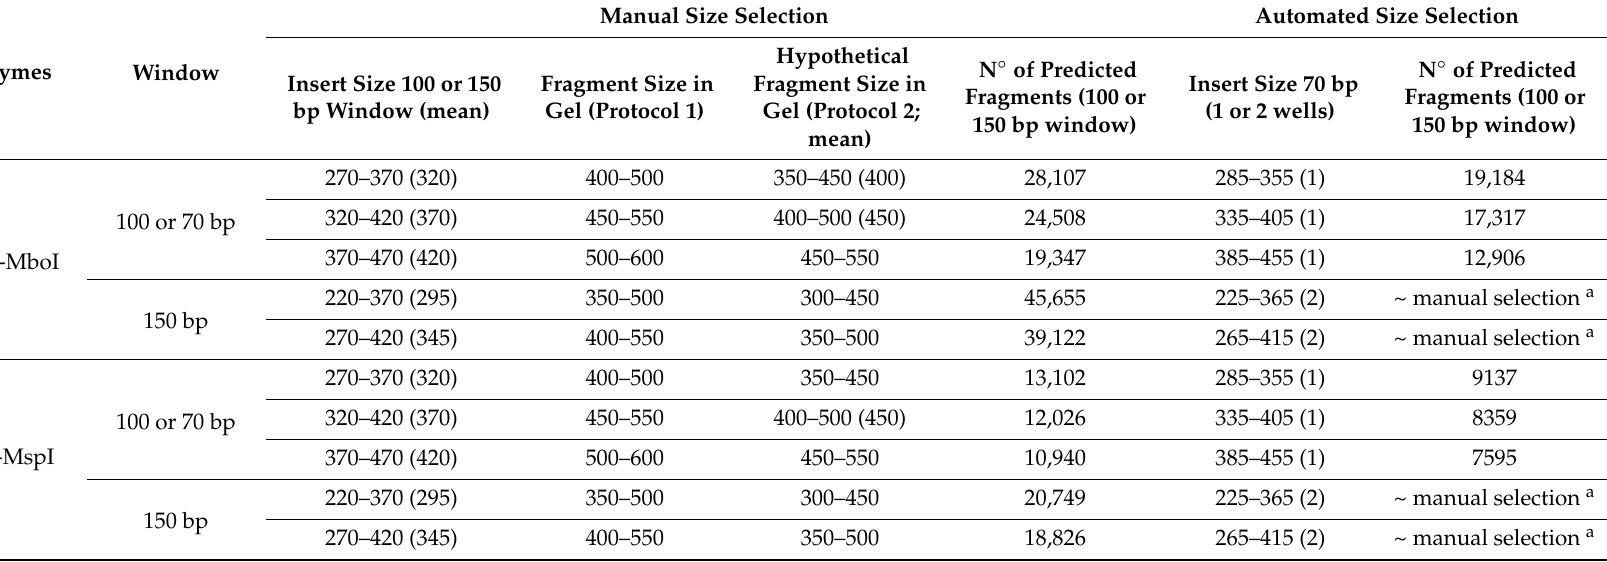
Table 1. Subpopulations of fragments obtained by in silico simulations of E. grandis genome